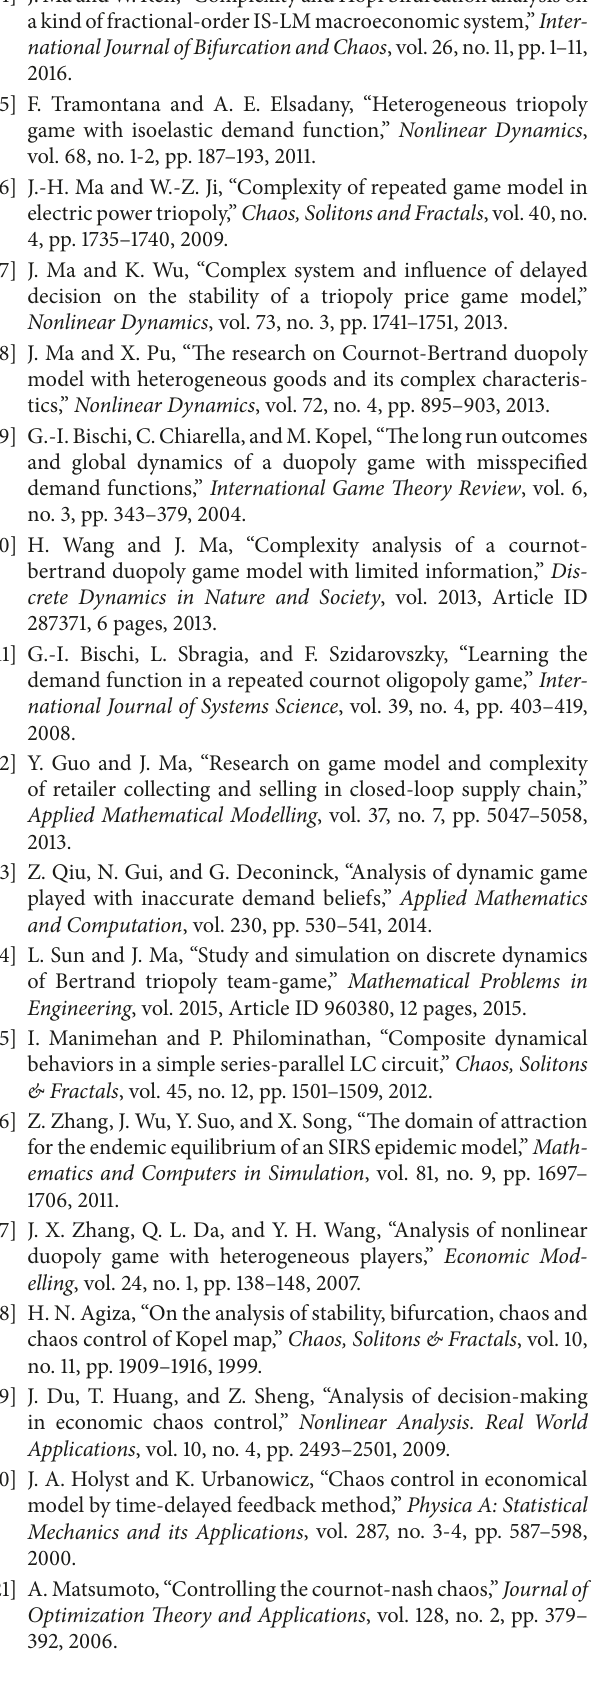
Figure 29: Basins of attraction, 𝛼 = 0.3 , 𝛽 = 0.25 , and 𝑞 3 = 5 .